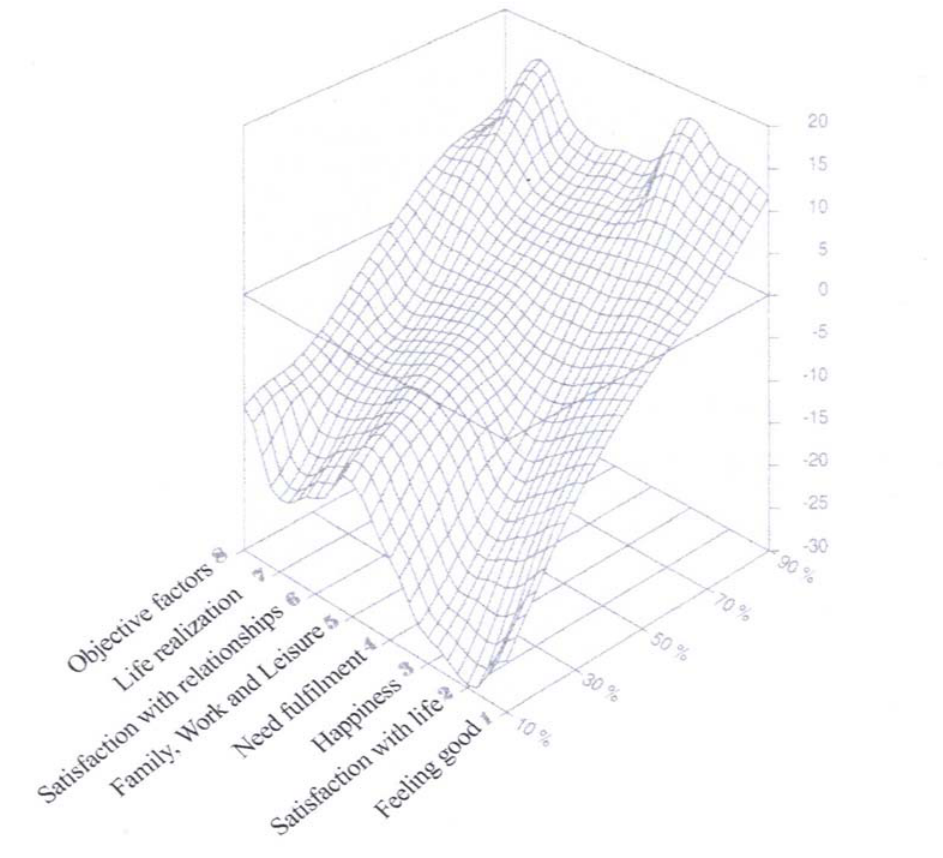
FIGURE 1. Quality of life (z-axis), as measured according to eight quality-of-life theories (y-axis), against satisfaction with sex life (x-axis). Data from Table 3,